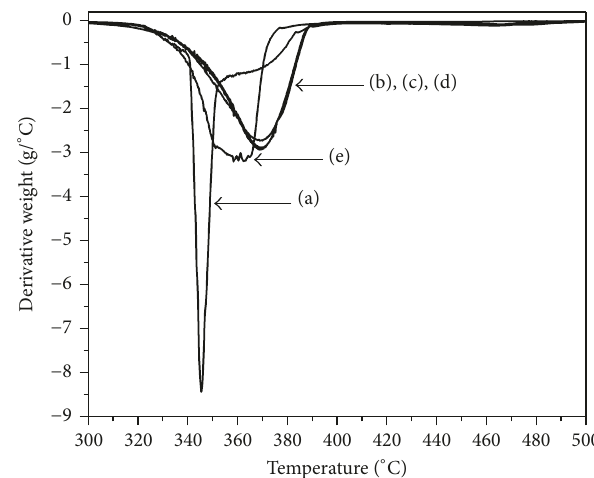
Figure 5: DTGA thermograms of thePLA-PNSP biocomposites: (a) neat PLA, (b) 5% wt. PNSP defatted, (c) 7.5% wt. PNSP defatted, (d) 5% wt. PNSP untreated, and (e) 7.5% wt. PNSP